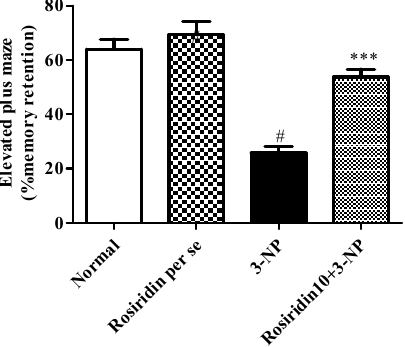
Figure 4. Effect of rosiridin on the elevated plus-maze test. Values are expressed as the mean ± SEM (n = 6). Values are statistically significant at p < 0.05 (one-way ANOVA followed by Dunnett’s test). Express the data ( # p < 0.05) saline vs. negative control group; (*** p < 0.001) negative control group vs. treatment group.